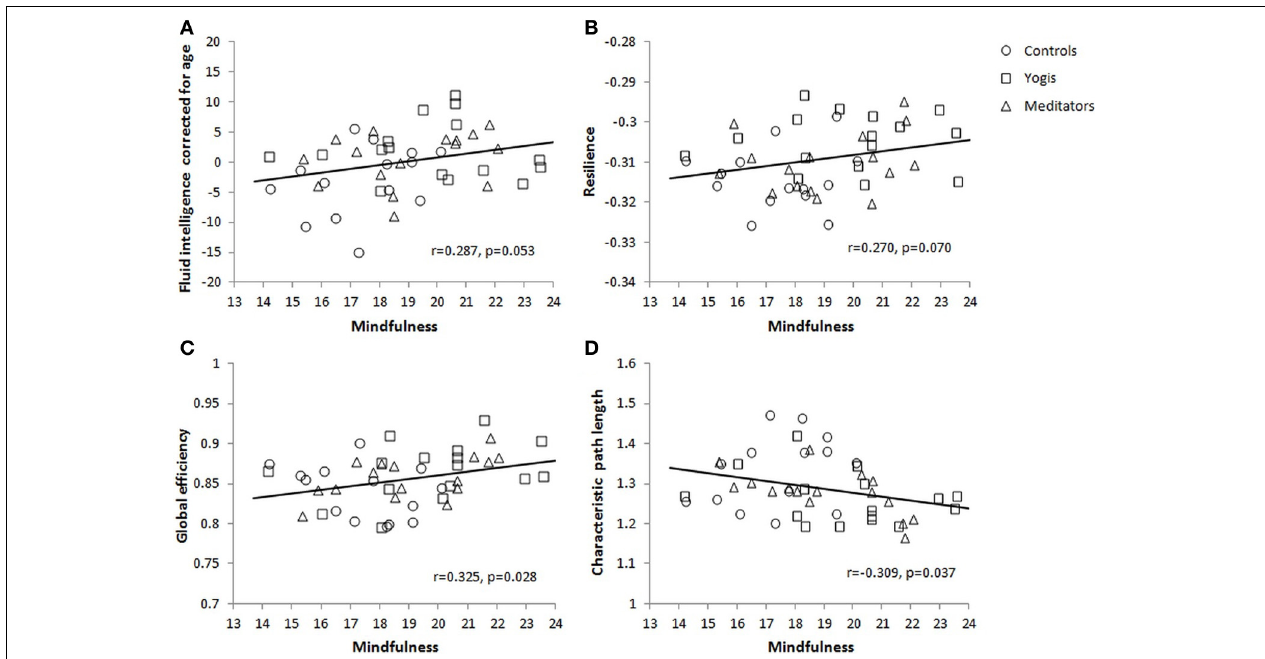
FIGURE 5 | Correlations between mindfulness and (A) fluid intelligence as measured with the Raven’s Advanced Progressive Matrices and corrected for age, (B) brain functional network resilience for targeted damage of 15 nodes, (C) global efficiency, and (D) characteristic path length.